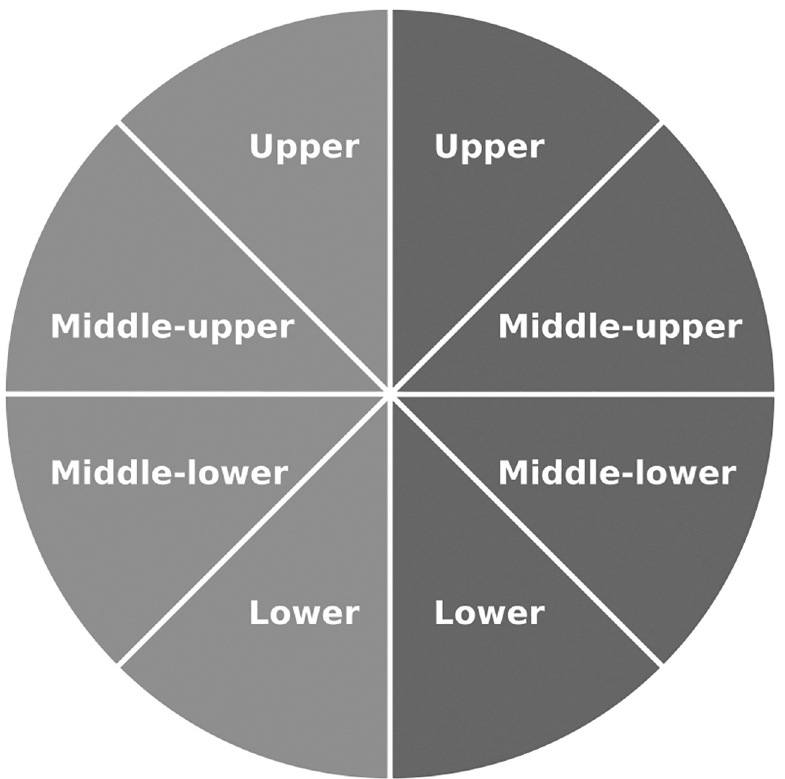
Fig 3. The division of hemifields into quadrants. The left hemifield is shown in light grey and the right hemifield in dark grey.